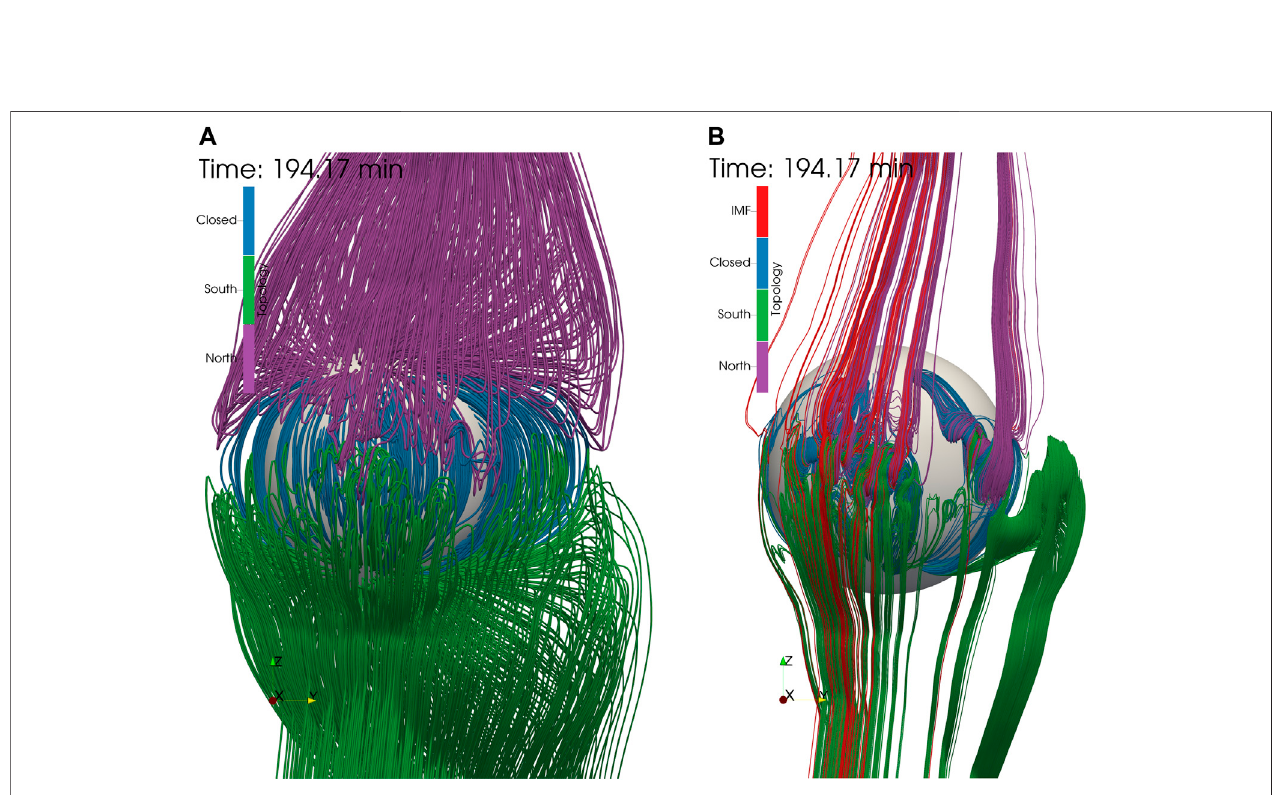
FIGURE 5 | By fi ltering fi eld lines by rotation, fl ux rope structure can more easily be seen. Panel (A) shows fi eld lines drawn from a regular spherical grid. Panel (B) shows fi eld lines drawn from positions on the simulation grid with a high enough rotation, Λ > 8 π .